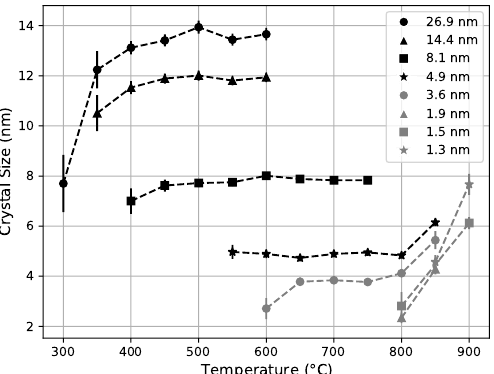
Figure 6. Zirconia crystal size as a function of annealing temperature. The crystal size is calculated from the crystallization peak width, with error bars representing statistical errors in the peak fits. Here, we can clearly see the breakdown of the silica barrier at 800 ◦ C as the crystal size is larger than the zirconia layer size. The thicknesses in the legends refer to the zirconia layer thickness of the sample, described in Table 1. Points not shown for lower temperature are all consistent with zero